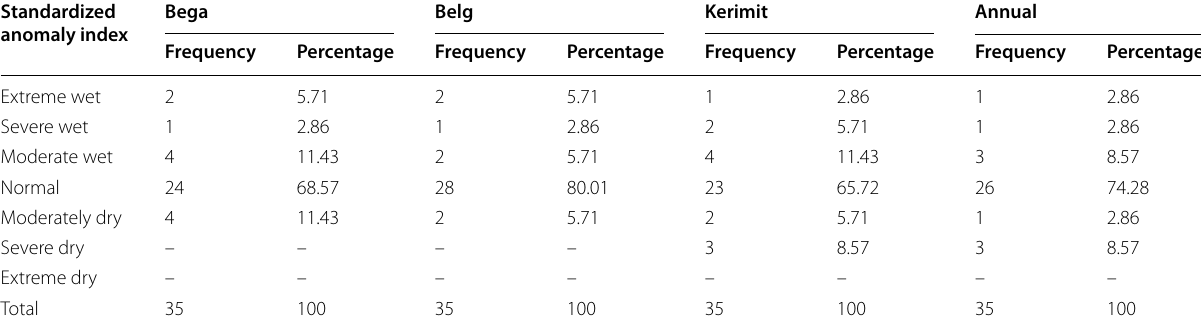
Table 2 Annual and Seasonal rainfall Standardized anomaly index category Standardized anomaly